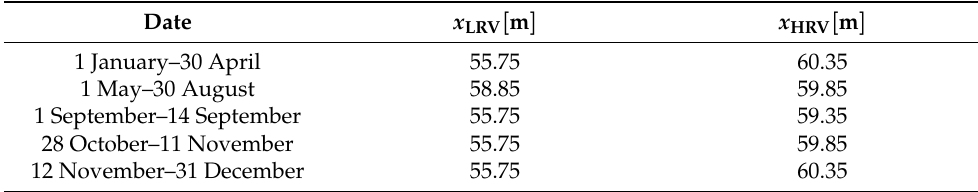
Table 2. Seasonal level